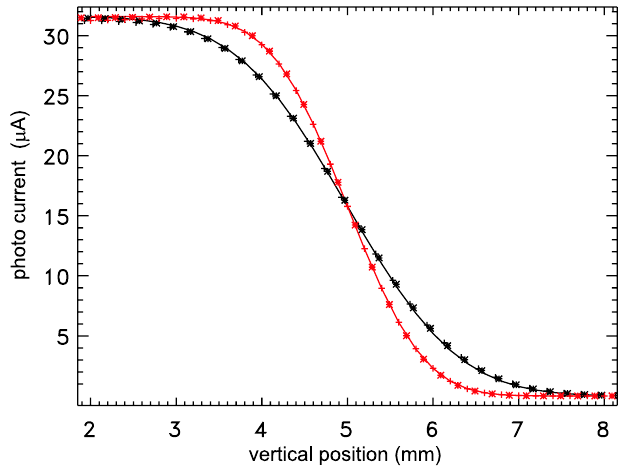
FIG. 16. (Color) Signal of a 10 mm (cid:2) 10 mm area photodiode with 8 (cid:9) m Al filter while being moved vertically into ( (cid:8) ) and out of ( þ ) the synchrotron radiation beam. The solid line is the appropriate calculation according to the Schwinger theory. The black and red graphs are for the MLS operated with and without vertically coupled beams at 630 MeV,